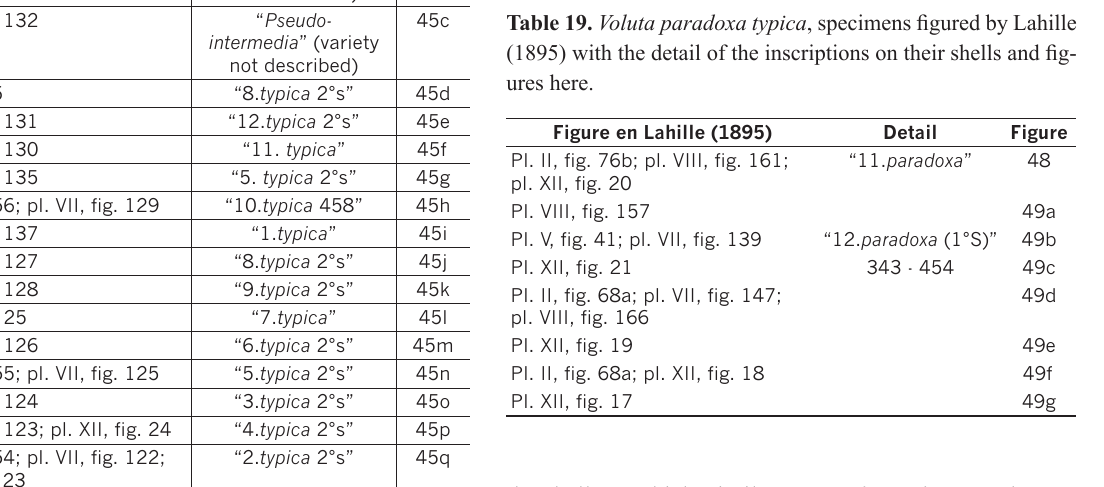
Pl. X, fig. 8 529 “1. Pseudo-intermedia ” (variety not described)